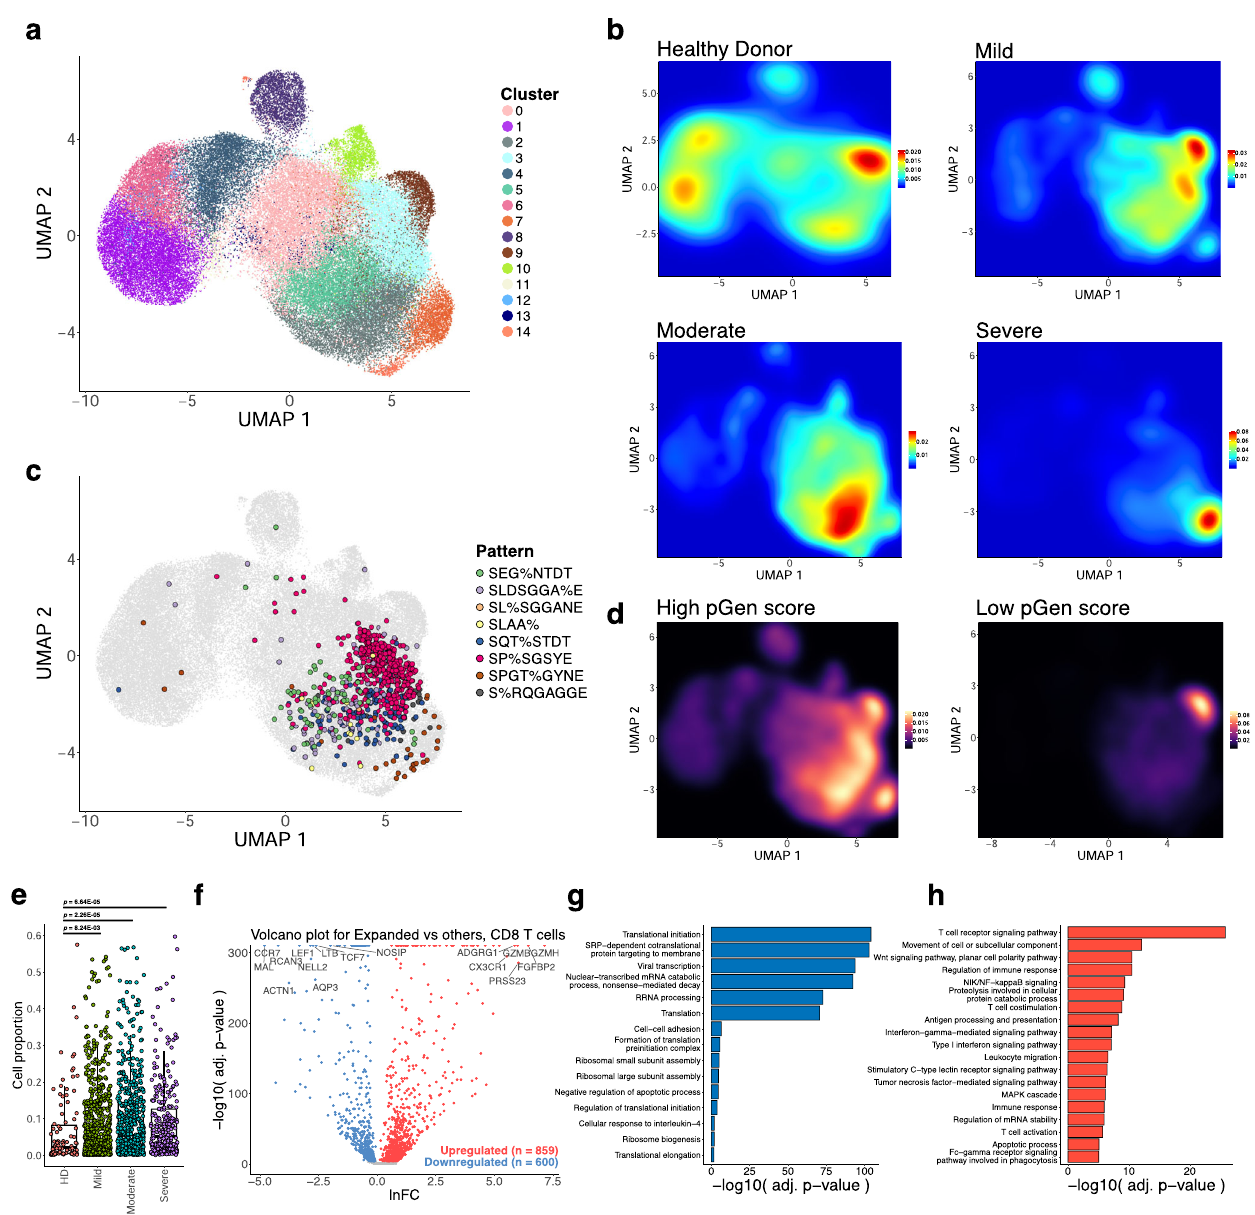
Fig. 4 Single-cell transcriptional signatures of clonal expansion of CD8 T cells. a UMAP visualization of 70,237 CD8 T cell single-cell transcriptomes from the ISB-S CD8 dataset pooled across samples and conditions. 15 clusters identi fi ed using the Louvain algorithm. b Two-dimensional density plot of cells from each disease condition (healthy donor, mild, moderate, severe) by UMAP coordinates. Red represents areas of high density of cells of a given condition; blue represents areas of low density. c UMAP visualization with cells labeled by top eight most frequent CD8 TCR clusters identi fi ed by the GLIPH2 analysis. d Two-dimensional density plot of cells with high or low pGen score clonotypes by UMAP coordinates. Yellow represents areas of high density of cells; black represents areas of low density. e Boxplots of clonally expanded cell proportions (in Expanded group) for each disease condition (cell count healthy donor = 2579, mild = 18,622, moderate = 15,743, severe = 7159). Comparison between groups performed with two-sided Wilcoxon rank- sum test. f Volcano plot of differentially expressed genes between clonally expanded cells and all other cells in the ISB-S CD8 dataset (Expanded group cells = 5000, all other cells = 5000). Differential gene expression was performed with Seurat using the two-sided Wilcoxon rank-sum test; the Bonferroni corrected adjusted p -values and log fold-change of the average expression were used for visualization. g Bar plot of biological processes (BP) pathway terms associated with downregulated genes (clonally expanded cells vs all other cells, q -value < 1e-4) by DAVID analysis. h Bar plot of biological processes (BP) pathway terms associated with upregulated genes (clonally expanded cells vs all other cells, q -value < 1e-4) by DAVID